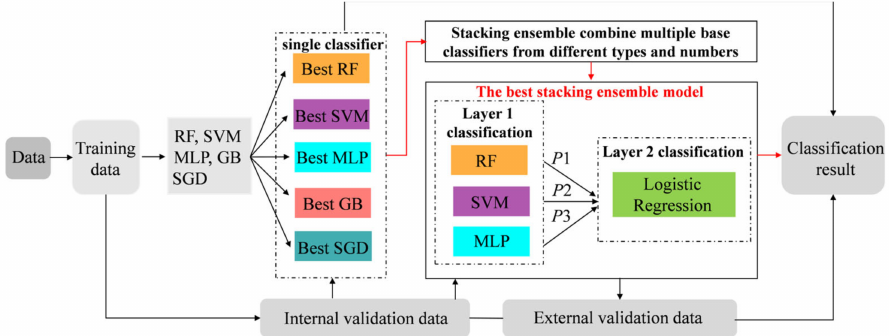
Figure 1. The flow chart of model training and